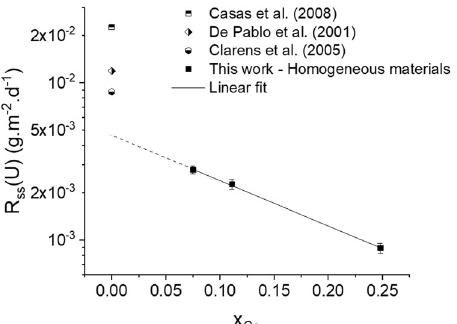
Fig. 10 Comparison of leaching rates. Normalized leaching rate R ss determined for homogeneous materials as a function of the cerium content (for [H 2 O 2 ] = 0.20 mmol.L − 1 , [HCO 3- ] = 0.16 mmol.L − 1 , pH = 7.0 ± 0.2 and T = 22 °C). Comparison with data reported in the literature for pure UO 2 . Error bars are standard error of the